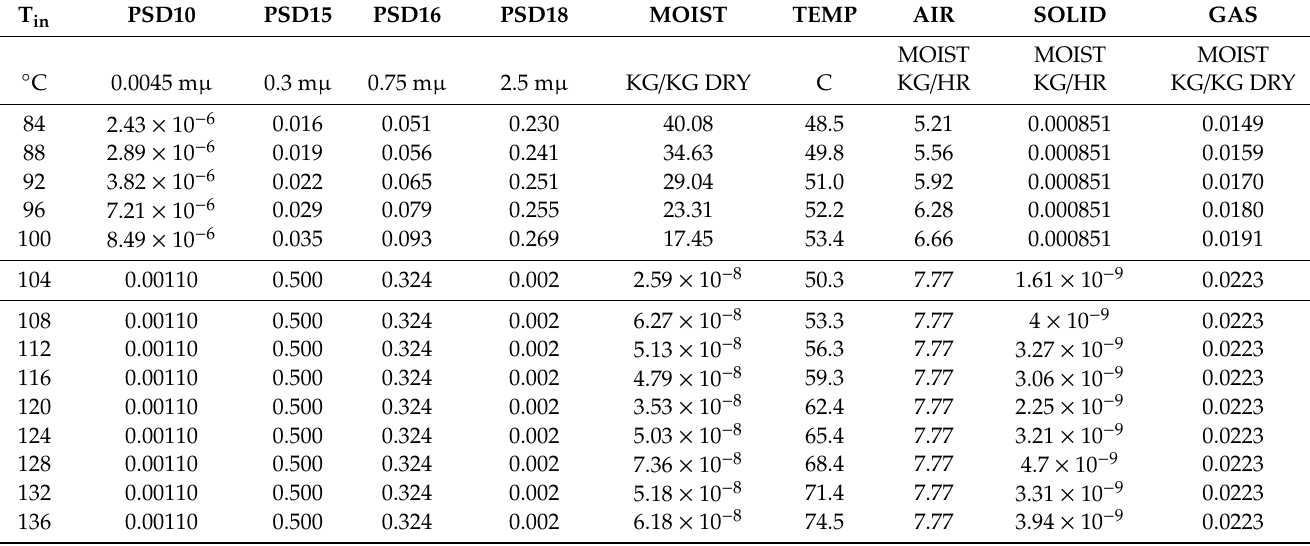
Table 11. Particle size distribution, air inlet and outlet temperature, IBU and gas moisture content, air solid and gas moisture feed are presented. The predicted operational space is pointed out inside the frame covering all process parameters of the industrial